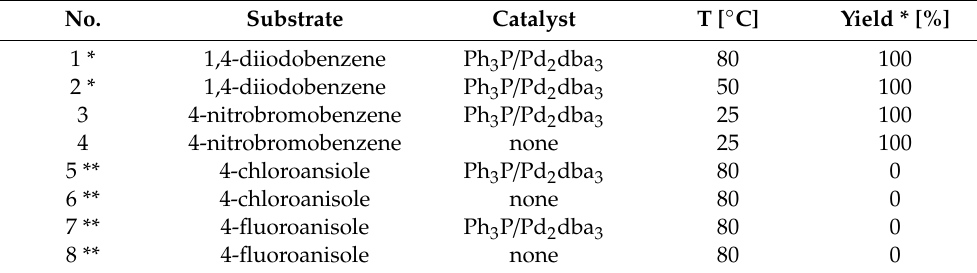
Table 3. Screening of further